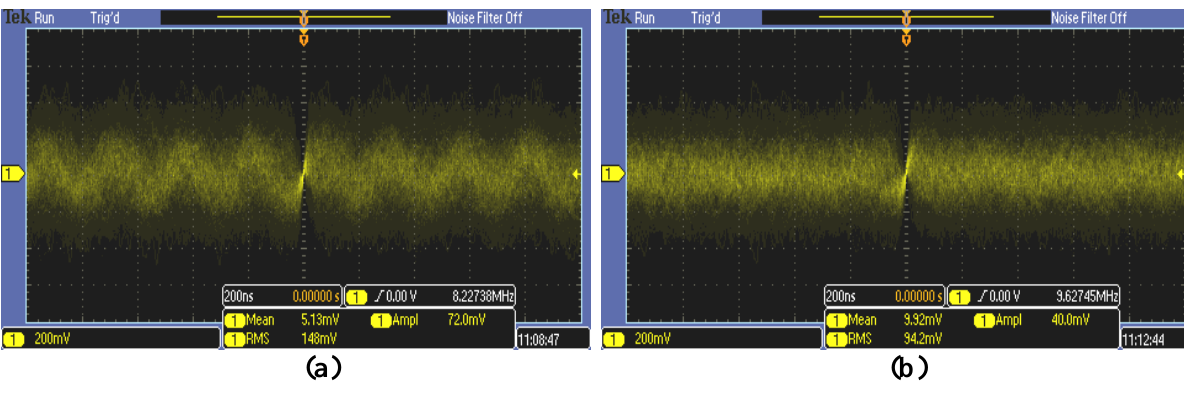
Figure 10. Signals in the output of the receiver: (a) Best case: (2.5 m, 0°); (b) Worst case: (3.5 m,